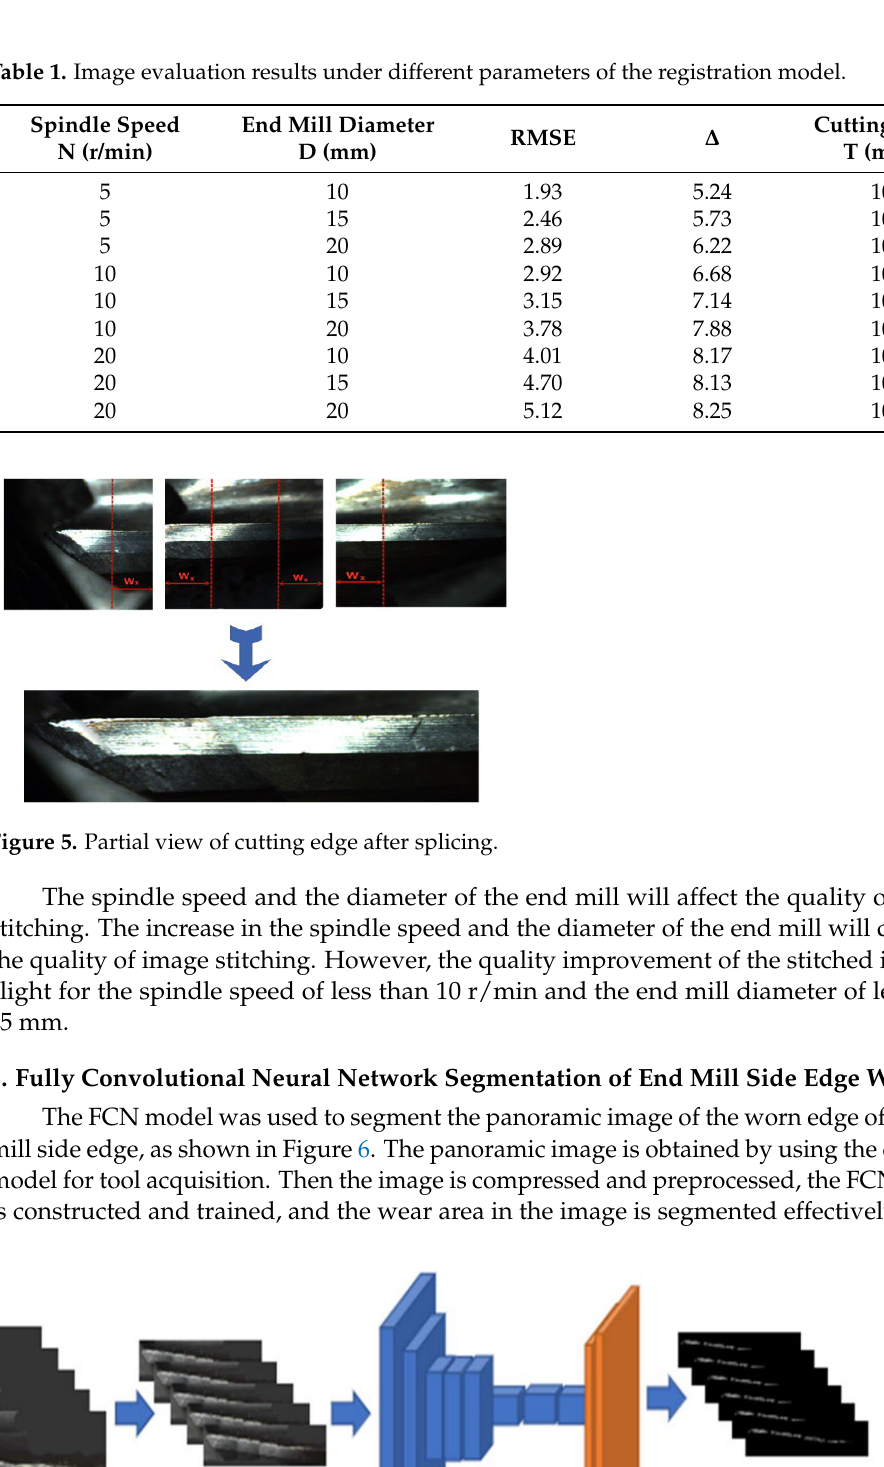
Table 1. Image evaluation results under different parameters of the registration model.